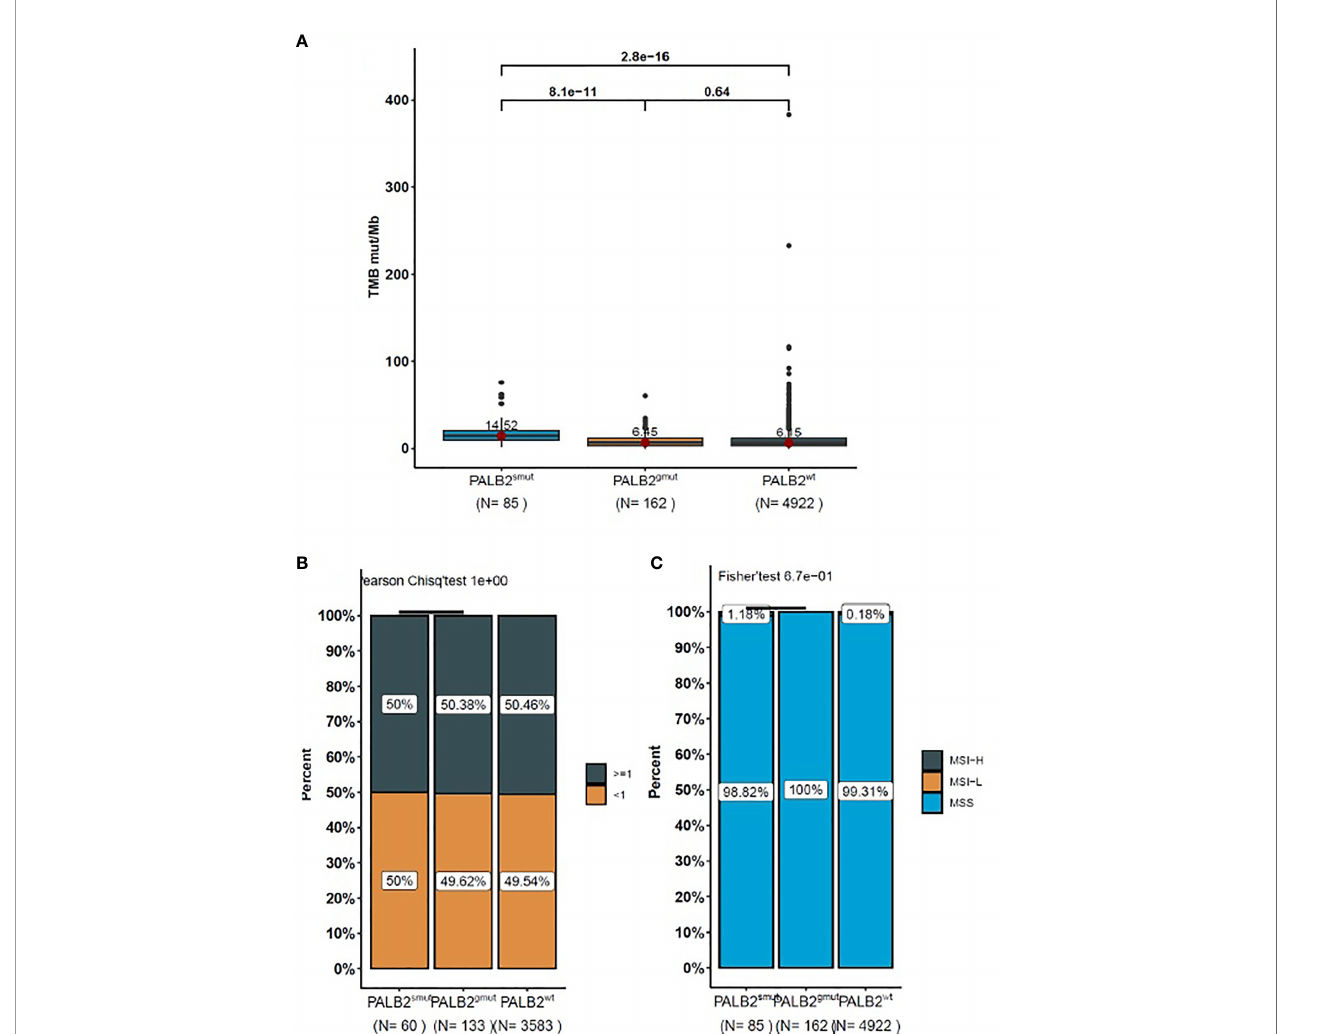
FIGURE 3 | The box-plot for the level of (A) TMB, (B) PD-L1, and (C) MSI in NSCLC patients with PALB2 mutations. The data presented in panels (A – C) represent the mean values of four samples (± standard deviation) and were analyzed with Student ’ s t